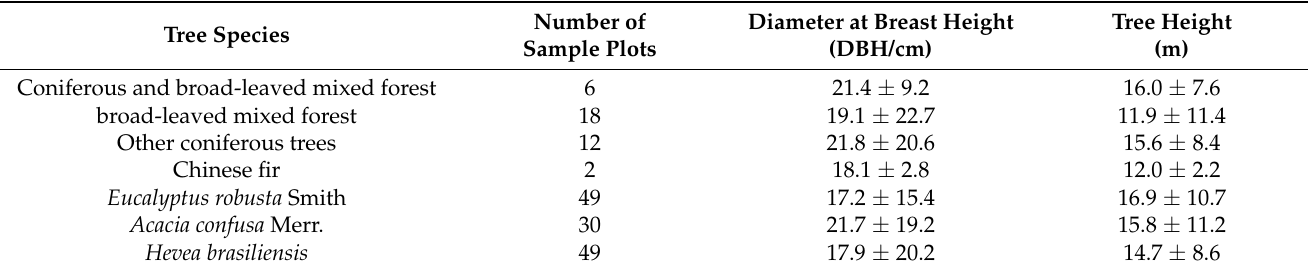
Table 2. Sample plots